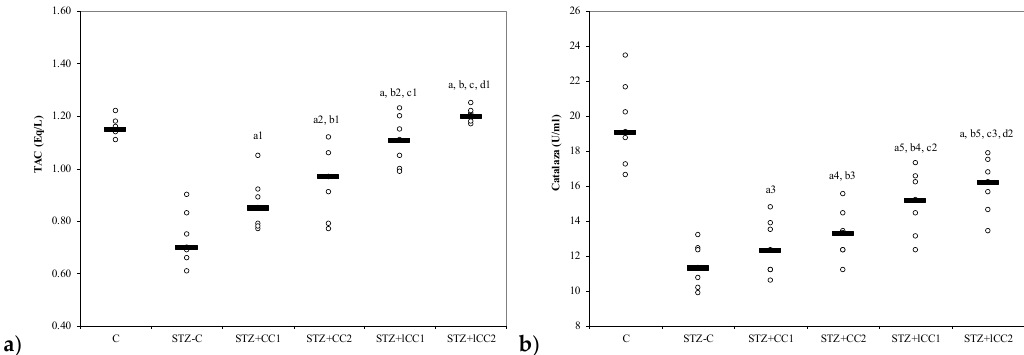
0.400.600.801.001.201.401.60 Figure 2. Variability of antioxidant capacity of plasma by groups: ( a ) total antioxidant capacity (TAC) and ( b ) catalase. C = control; STZ ‐ C = streptozotocin control; STZ + CC1 = STZ and 1 mg/100 g bw CC as pre ‐ treatment; STZ + CC2 = STZ and 2 mg/100 g bw CC as pre ‐ treatment; STZ + lCC1 = STZ and pre ‐ treatment with 1 mg/100 g bw lCC; STZ + lCC2 = STZ and pre ‐ treatment with 2 mg/100 g bw lCC. a p ‐ values < 0.002 as compared to STZ ‐ C group and a1 0.0350, a2 0.0088, a3 0.2502, a4 0.0409, and a5 0.0060, respectively; b p ‐ values < 0.002 as compared to STZ + CC1 group excepting b1 0.2248, b2 0.0049, b3 0.4433, b4 0.0253, and b5 0.0088; c p ‐ values < 0.002 as compared to STZ + CC2 group excepting c1 0.0253, c2 0.0845, and c3 0.0060; d p ‐ values as compared to STZ + lCC1 group: d1 0.0476, d2 0.2502. Figure 3. Variability of ( a ) glycemia, ( b ) AST (aspartate aminotransferase) and ( c ) alanine aminotransferase (ALT) by groups. C = control; STZ ‐ C = streptozotocin control; STZ + CC1 = STZ and 1 mg/100 g bw CC as pre ‐ treatment; STZ + CC2 = STZ and 2 mg/100 g bw CC as pre ‐ treatment; STZ + lCC1 = STZ and pre ‐ treatment with 1 mg/100 g bw lCC; STZ + nCC2 = STZ and pre ‐ treatment with 2 mg/100 g bw lCC. a p ‐ values < 0.002 as compared to STZ ‐ C group; b p ‐ values < 0.002 as compared to STZ + CC1 group excepting b1 0.0152, b2 0.0027, and b3 0.0060; c p ‐ values < 0.002 as compared to STZ + CC2 group excepting c1 0.0040; d p ‐ values < 0.002 as compared to STZ + lCC1 group excepting d1 0.0040.